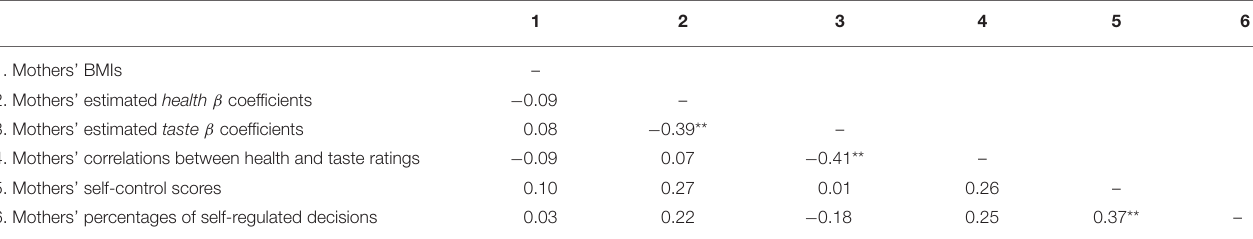
TABLE 3 | Correlations for dynamics of unhealthy food decision-making in